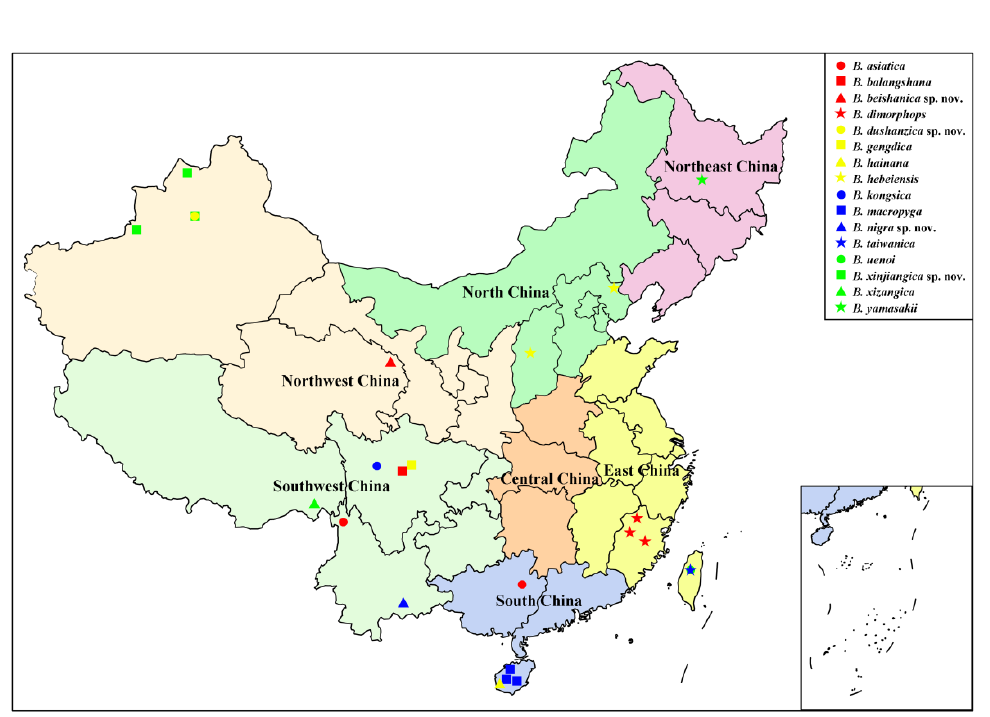
Figure 14. Distribution map of Blepharicera in China.